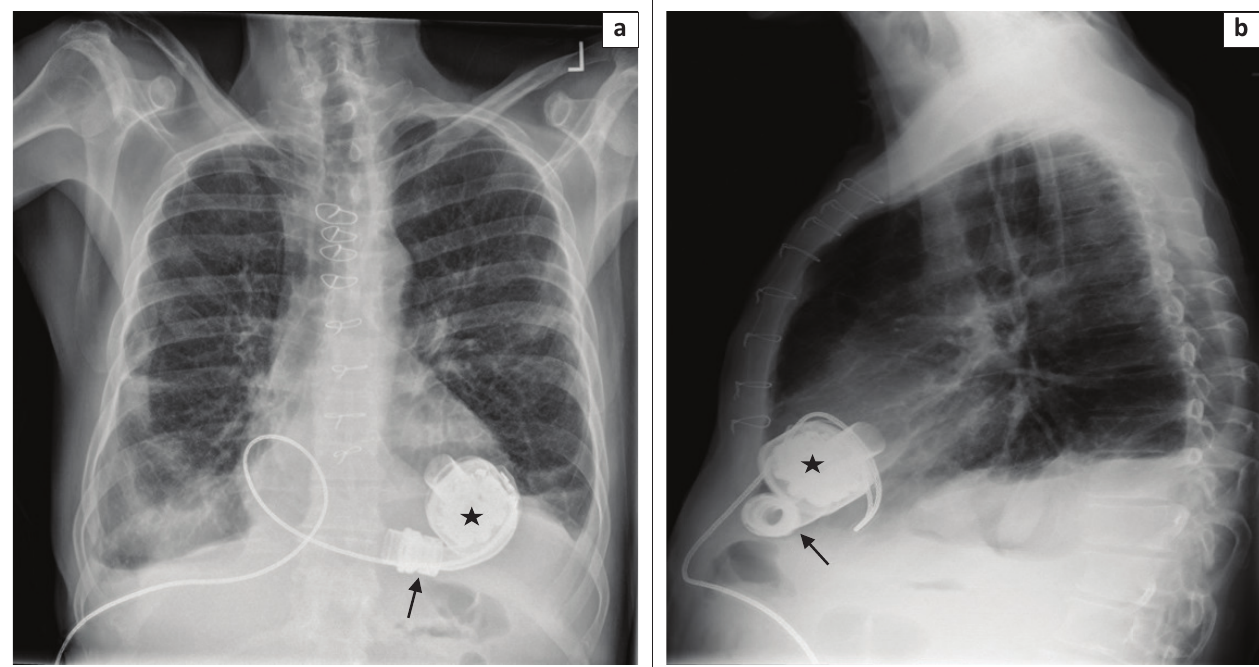
FIGURE 10: Frontal (a) and lateral (b) chest radiographs showing a HeartMate III device implanted in a 58-year-old male with severe left ventricular dysfunction. Note that the HMIII device has an angled outflow cannula (arrow) and a circular impeller unit (star).